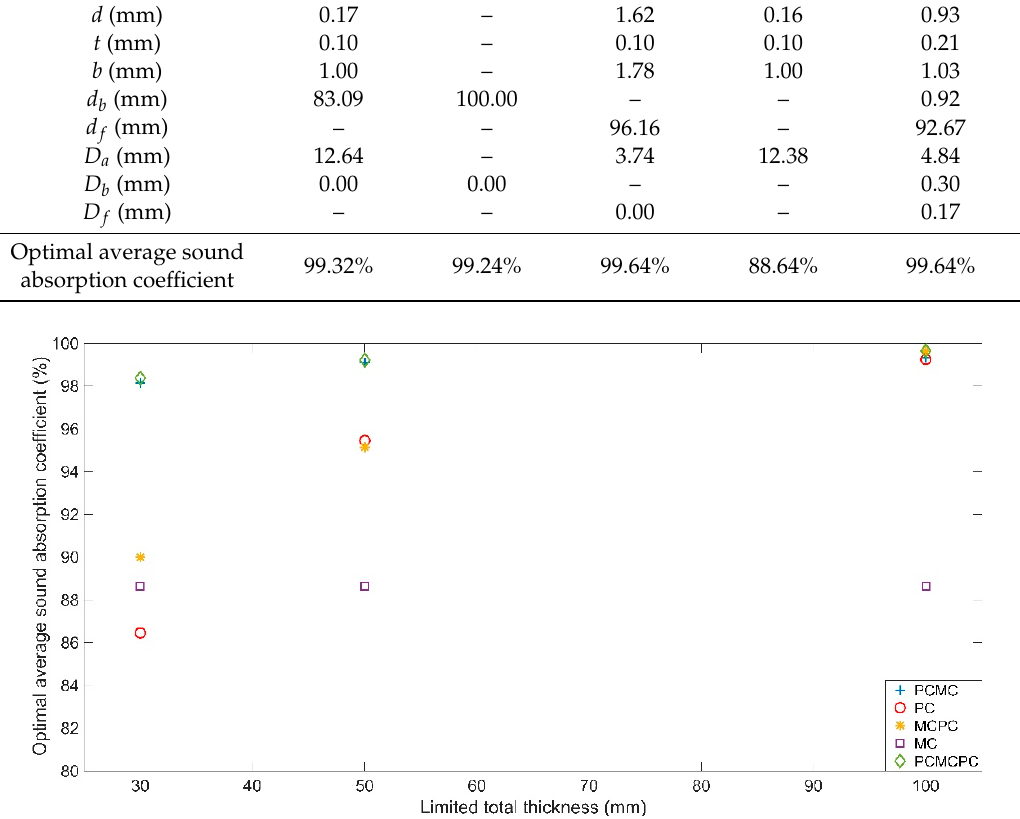
Figure 3. Comparisons of theoretical optimal average sound absorption coefficients of the composite structures with the different limited total thickness of 30 mm, 50 mm, and 100 mm.